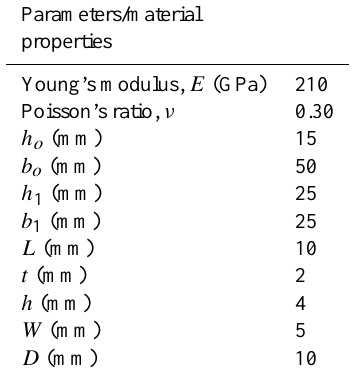
Table 1. Geometrical parameters and material properties of the compliant micro-motion